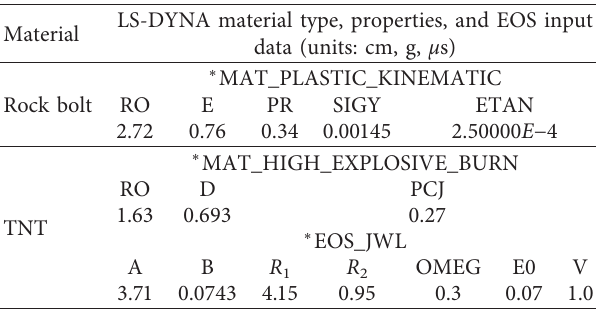
Table 3: LS-DYNA material type, properties, and EOS input data.